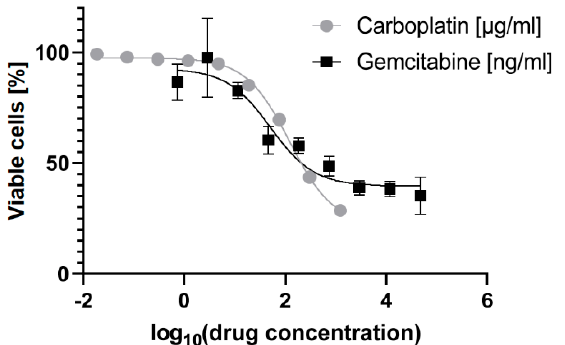
Figure 1. The dose-response curves determined using the MTT assay of the hematopoietic stem and progenitor cells (HSPCs) treated for 24 h with gemcitabine in log 10 (ng/mL) and carboplatin in log 10 (µg/mL). The error bars denote the standard deviation.